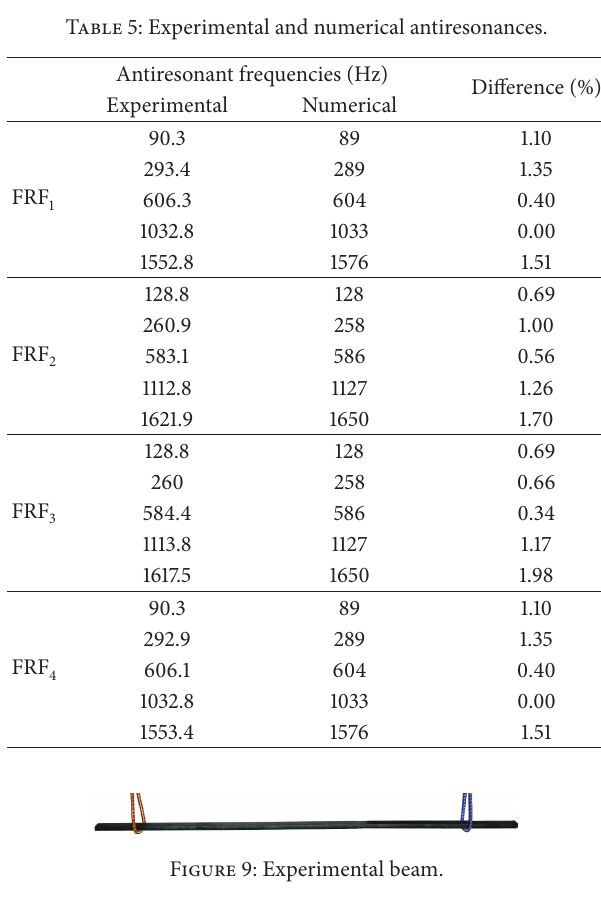
Figure 9: Experimental